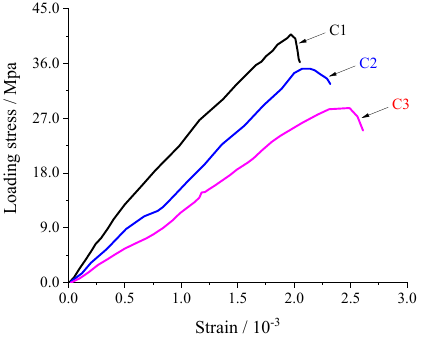
Figure 7. Stress–strain curve with different amounts of graphite powder.